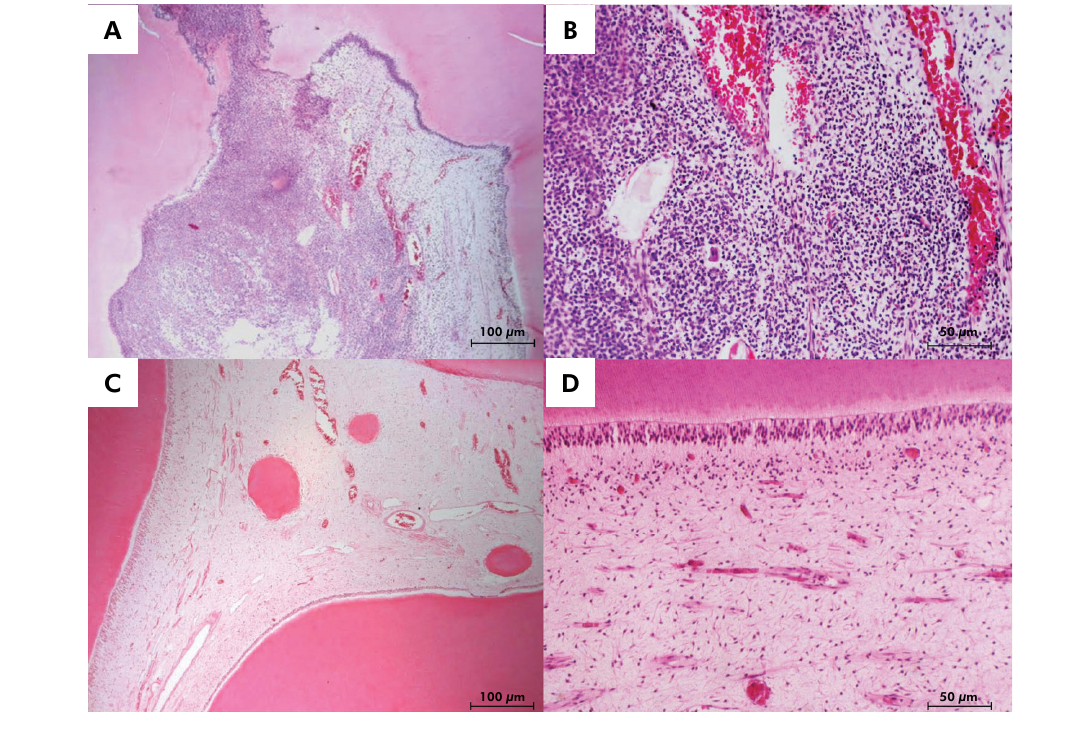
Figure 1. (A, B) Morphological characteristics detected in irreversible pulpitis samples. There are areas of disorganization in the odontoblastic layer, congested vessels, and intense, predominantly mononuclear inflammatory infiltrate. (C, D) Morphological characteristics observed in healthy pulps samples. Preserved odontoblastic layer, possible calcifications, and no signs of inflammation are present (hematoxylin and eosin, ×20 and ×40,